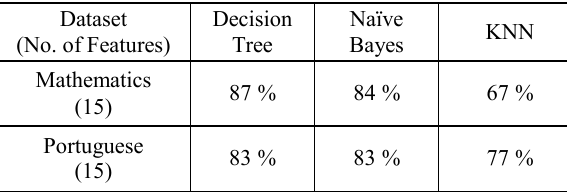
Table 5. Classification report with single feature selection (Chi-2) method.